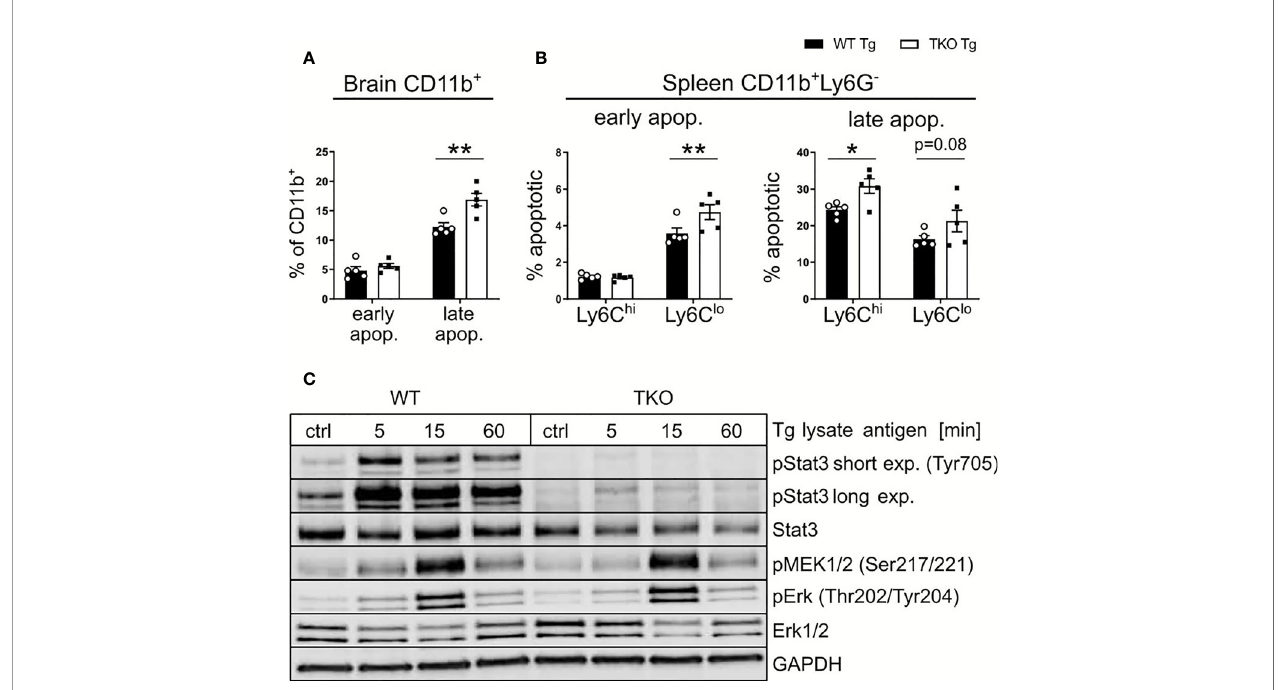
FIGURE 8 | Altered STAT3 signaling in TKO APCs. Immune cells were isolated from the brain and spleen tissue of T. gondii -infected WT (WT Tg, n=5) and TKO (TKO Tg, n=5) mice on day 28 p.i. and analyzed by fl ow cytometry. (A, B) Isolated cells were stained with Annexin V and 7AAD to determine early apoptotic (7AAD - AnnexinV + ) and late apoptotic (7AAD + AnnexinV + ) cells. (A) Percentage of early and late apoptotic CD11b + cells isolated from brain tissue. (B) Percentage of early and late apoptotic Ly6C hi and Ly6C lo mononuclear cells isolated from spleen. (C) Bone marrow derived macrophages from WT and TKO mice were treated with 30 m g/ml toxoplasma lysate for the depicted time. Proteins were isolated and quanti fi ed via Bradford assay and immunoblotted using pMEK (Ser217/221), Erk, pErk (Thr202/Tyr204), Stat3, pStat3 (Tyr705) and GAPDH antibodies. For apoptosis assay, n=5. Data shown in (A, B) represent three independent experiments; symbols represent individual animals, columns represent mean values and error bars represent ± SEM. Data shown in (C) represents a representative of three independent experiments. 2way ANOVA followed by Fisher ’ s LSD test was used for statistical analysis. *P < 0.05, **P <